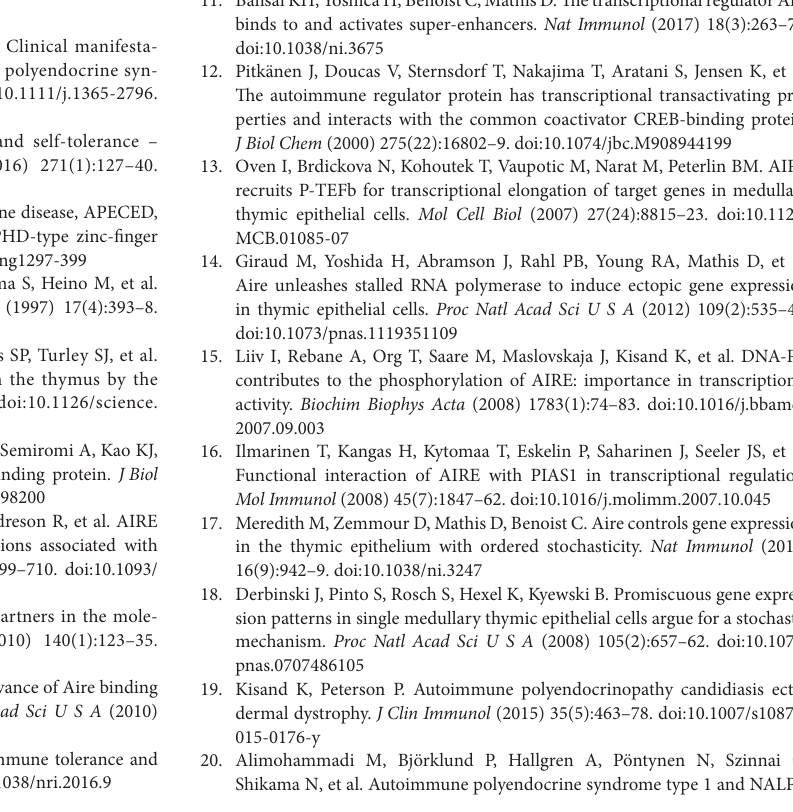
FigUre s1 | Gene expression profile of TEC 1A3 AIRE lo cells vs relative change in expression between AIRE hi and AIRE lo cells. Gene expression values are averaged from three replicates and calculated relative change in expression values for all probes on the Human Genome U133 Plus 2.0 gene array. All dots show probes with a significant change in expression ( P ≤ 0.05) with differential expression found to be conserved in at least three of the murine microarray analyses used in the comparison. FigUre s2 | Full EdgeExpress DB output figure generated from list of human Entrez Gene IDs from conserved list of Autoimmune Regulator/Aire regulated genes using default settings. Node and edge colors and styles are as determined by EdgeExpress db. TaBle s1 | List of differentially expressed genes identified in t -test comparison of microarray data ( P ≤ 0.05 with Benjamini–Hochberg correction) generated